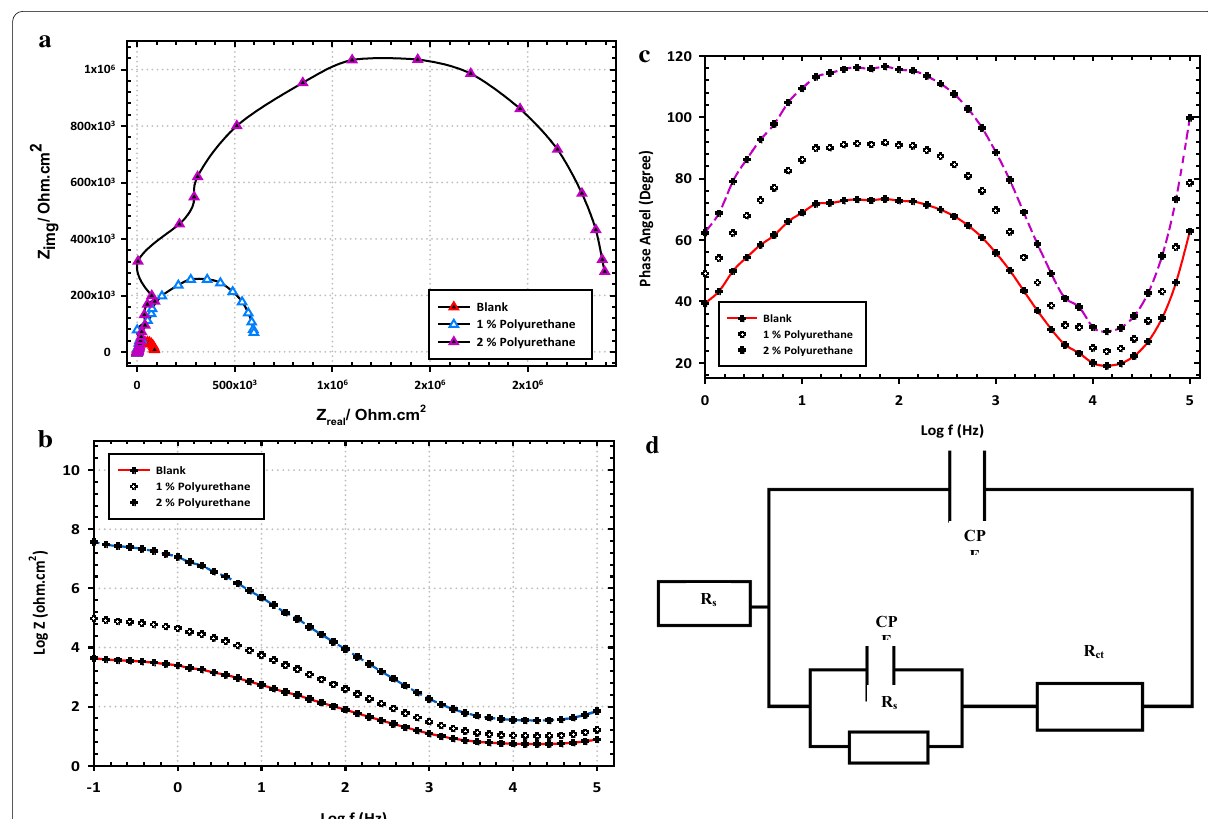
Fig. 11 EIS plots for cast iron in 3.5 wt% NaCl in the absence and presence of different concentrations of polyurethane at ambient temperature a Nyquist plots, b Bode plots, c phase angel, and d equivalent circuit